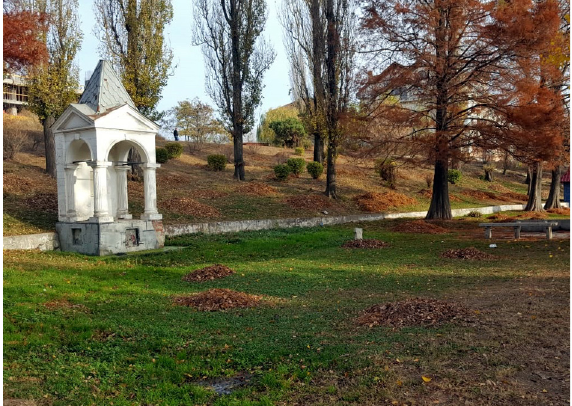
Fig. 9b. The Obedeanu well in November